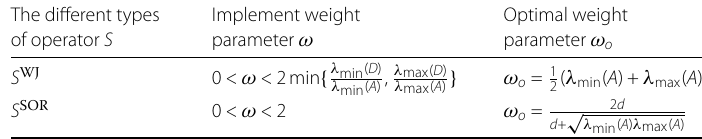
Table 3 Implemented weight parameter and optimal weight parameter of operator S The different types Implement weight of operator S parameter